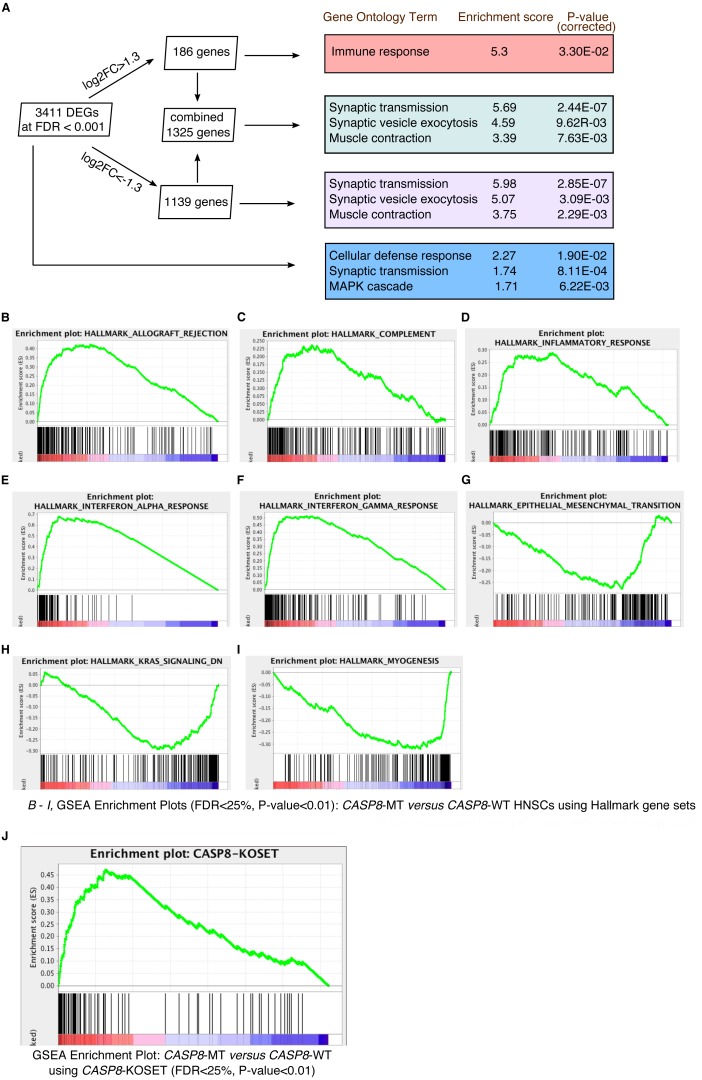
Gene enrichment analyses reveal a prominent immune signature in CASP8-MT HNSCs.Gene enrichment analysis was performed using tools available at the Gene Ontology Consortium (A), as well as using the Gene Set Enrichment Analysis tool (B–J). (A) Enrichment analysis was performed using genes with FDR < 0.001 and/or showing log2FC greater than 1.3 or less than −1.3. The top three gene ontology terms, based on enrichment scores, among the PANTHER GO-Slim Biological Processes significantly enriched in these gene lists are indicated along with Bonferroni-corrected P-values. (B–I) GSEA was performed using a pre-ranked list generated using log2FC values from the edgeR analysis. GSEA Hallmark gene sets enriched in CASP8-MT HNSCs (B–F) or CASP8-WT HNSCs (G–I) with FDR < 25%, P-value < 0.01, and showing enrichment at the top or bottom of the list are shown. (J) Enrichment plot of a GSEA performed with the same pre-ranked list that was analysed in (B–I) and a gene set of human orthologs of the genes up regulated in the skin epidermis of Casp-8F/−K5-Cre mice (CASP8-KOSET) is shown (FDR < 25%, P-value < 0.01).